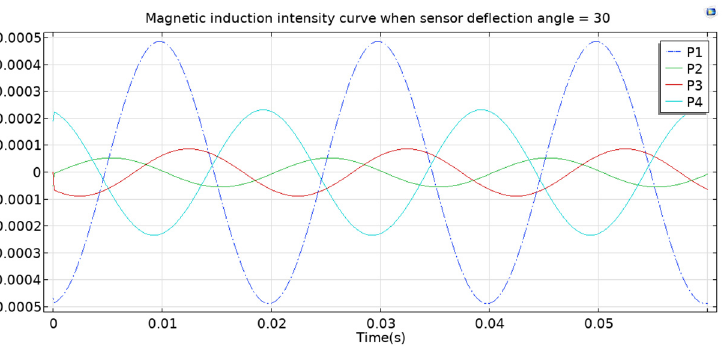
Figure 6. Magnetic induction intensity waveform when the de fl ection angle is 30 degrees.